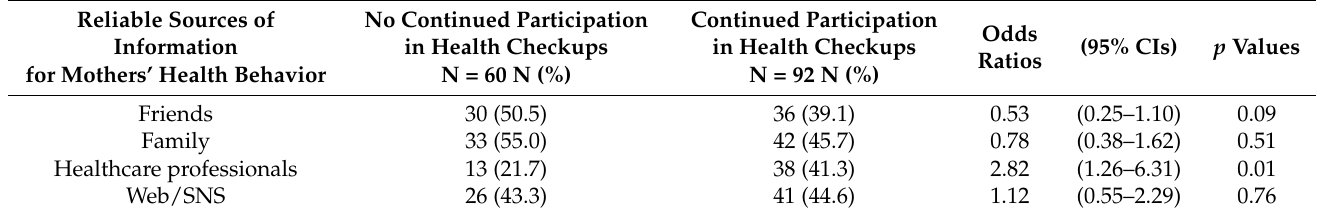
Table 3. Association between perceived reliability of sources of information regarding mothers’ health behavior and continued participation in health checkups (N =